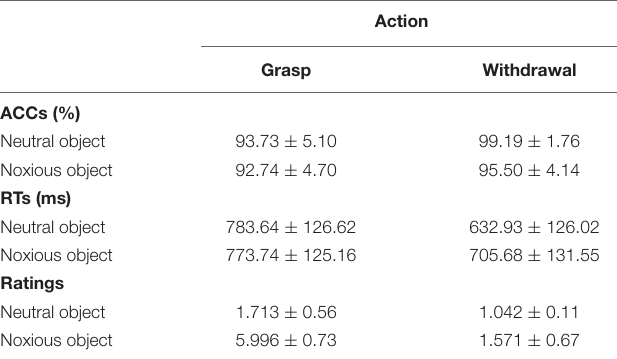
TABLE 1 | The first four columns present the two factors in the design and coding of each